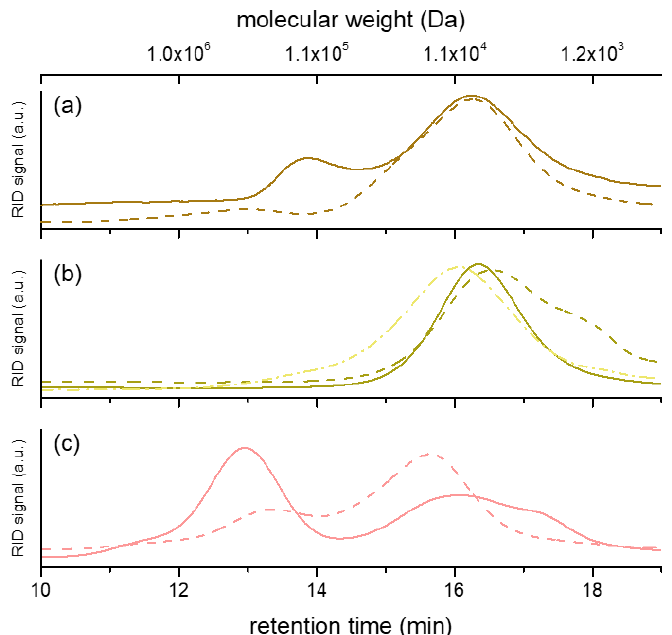
Figure 1. HPSEC chromatograms of the polysaccharide fractions produced from heart rot ( a ), sterile conk ( b ), and cultivated mycelium ( c ). Continuous line represents hot water extracts; dashed line represents alkali extracts. In ( b ), dotted and dashed line represents C-Chaga HW. The correspondence between molecular weight and retention time is based on the calibration curve (Figure S7).